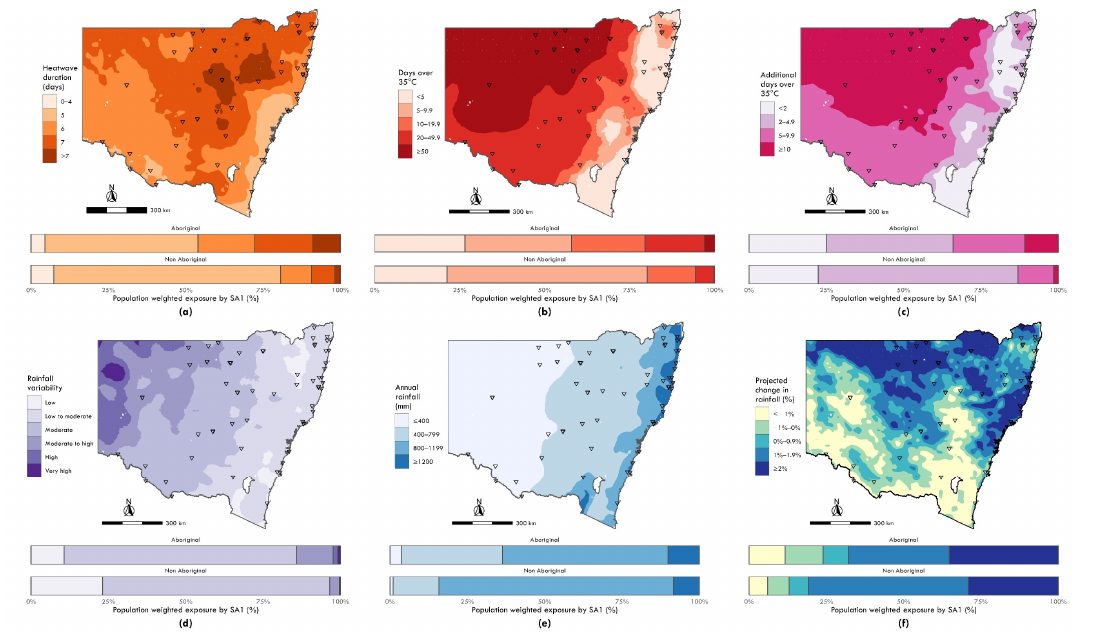
Figure 2. Maps of climate exposures with bar charts indicating relative exposure by category across